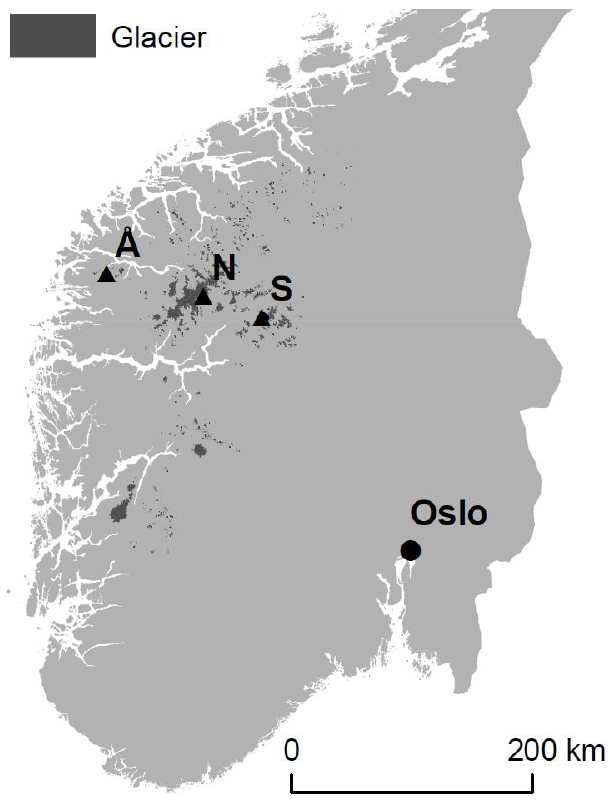
Fig. 1. Location of the study sites Ålfotbreen (Å), Nigardsbreen (N) and Storbreen (S) within the glacierised areas in southern Norway.